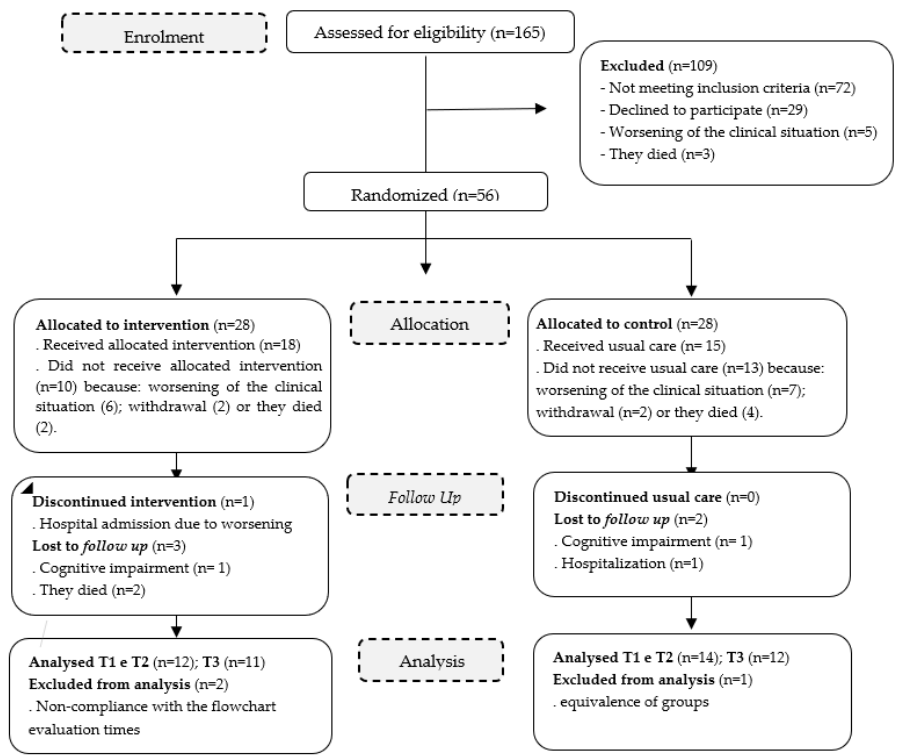
Figure 1. Participant flow through the phases of the